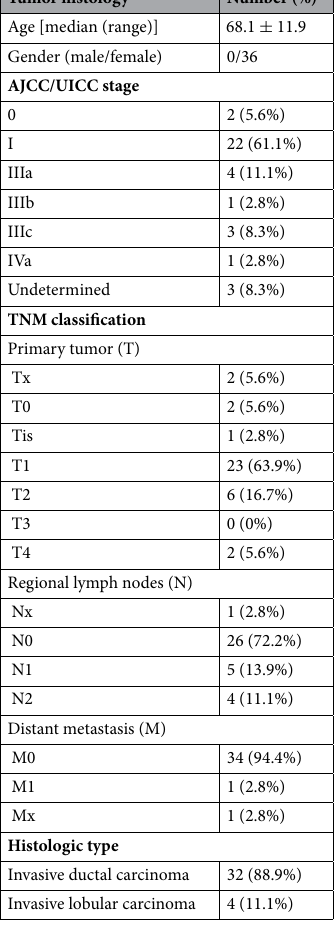
Table 1. Breast cancer (bc) type/staging in the analyzed